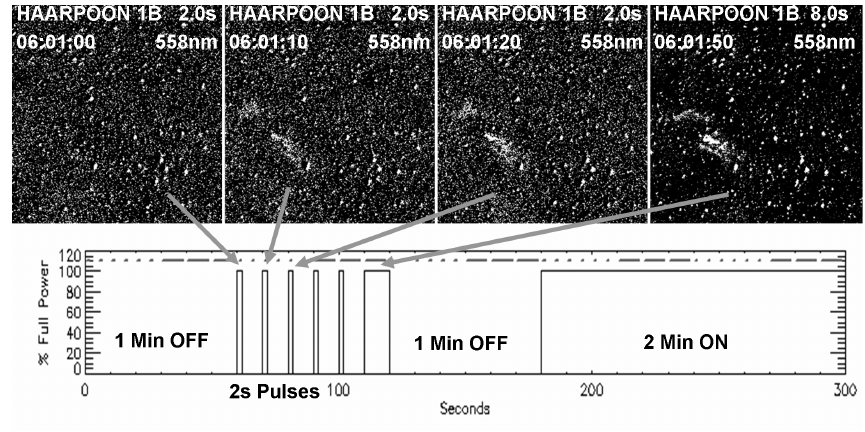
Fig. 4. Background-subtracted narrow-field ( ∼ 15 ◦ FOV) green line images from the magnetic zenith taken during short transmitter pulses on 30 March 2006. The bottom panel shows the 5-min transmitter power modulation scheme (black line) and the camera exposure sequence (dashed gray line near top of panel), which repeated every